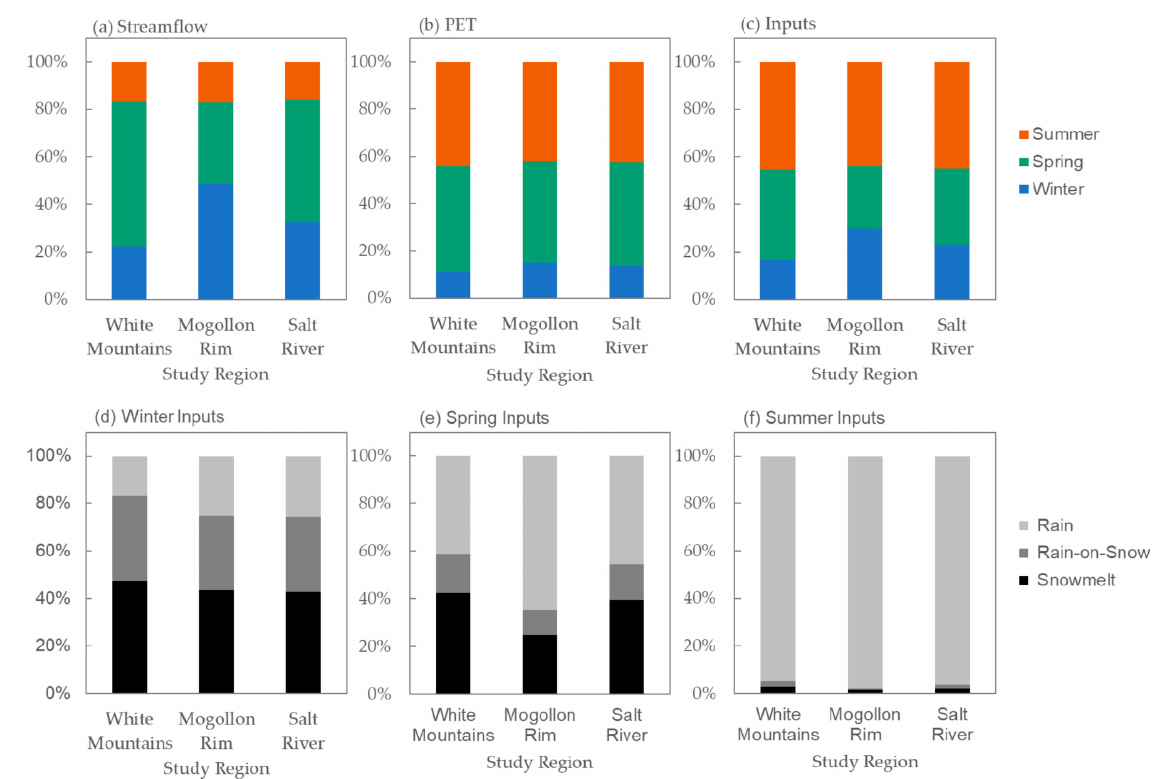
Figure 3. Seasonal mean percentages of annual streamflow ( a ), potential evapotranspiration (PET) ( b ), and hydrological inputs (sum of snowmelt, rain-on-snow, and rainfall) ( c ) summarized by White Mountain, Mogollon Rim, and Salt River regions from 1968–2011. Also shown are mean percent contributions of snowmelt, rain-on-snow, and rainfall in winter ( d ), spring ( e ), and summer ( f ). Seasons are winter (NDJF), spring (MAMJ), and summer